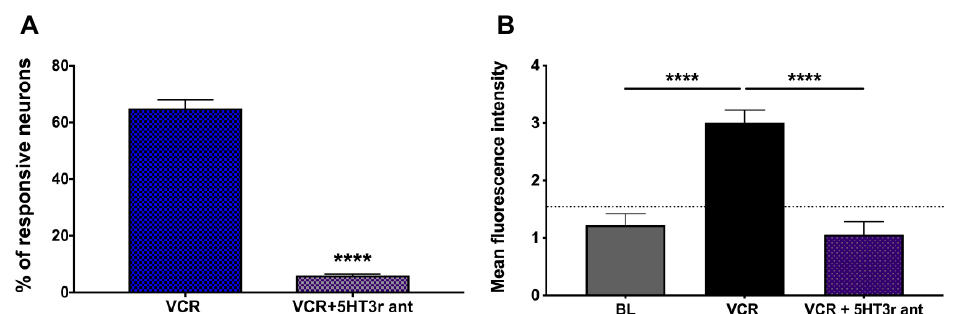
Figure 3. 5-HT3 receptor antagonist blocked vincristine-induced activation responses in gas- troesophageal vagal afferent neurons. ( A ) The percentage of responsive neuron in the vincristine (VCR, 1 μ M, 30 min) group was 65 ± 5% (167 out of 257 recorded neurons from three mice). In the group (VCR + 5HT3r ant) that was pretreated with palonosetron (10 μ M) for 30 min and then vin- cristine (1 μ M) was applied in the presence of palonosetron for 30 min, the percentage of vincristine responsive neurons went down to 6 ± 1% (19 out of 329 recorded neurons from three mice) (VCR vs. VCR + 5HT3r ant, **** p < 0.0001); ( B ) The mean fluorescence intensity in the VCR group was 3.005 ± 0.2195, which significantly went down to 1.056 ± 0.2043 in the palonosetron treatment (VCR + 5HT3r ant) group (VCR vs. VCR + 5HT3r ant, **** p < 0.0001).